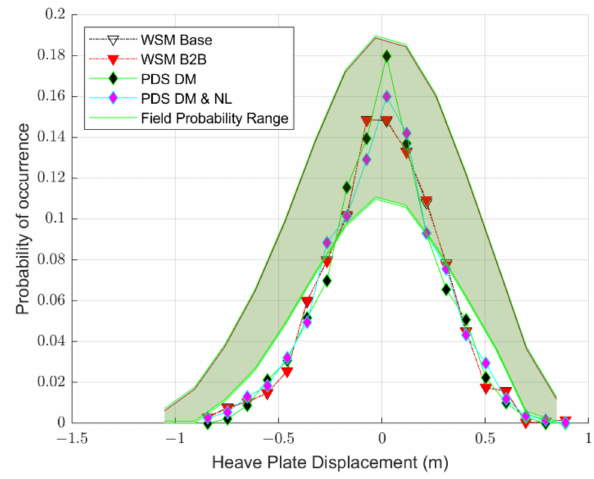
Figure 10. WEBS wave reconstruction heave plate displacement. Float angular velocity is directly proportional to WEBS extractable energy